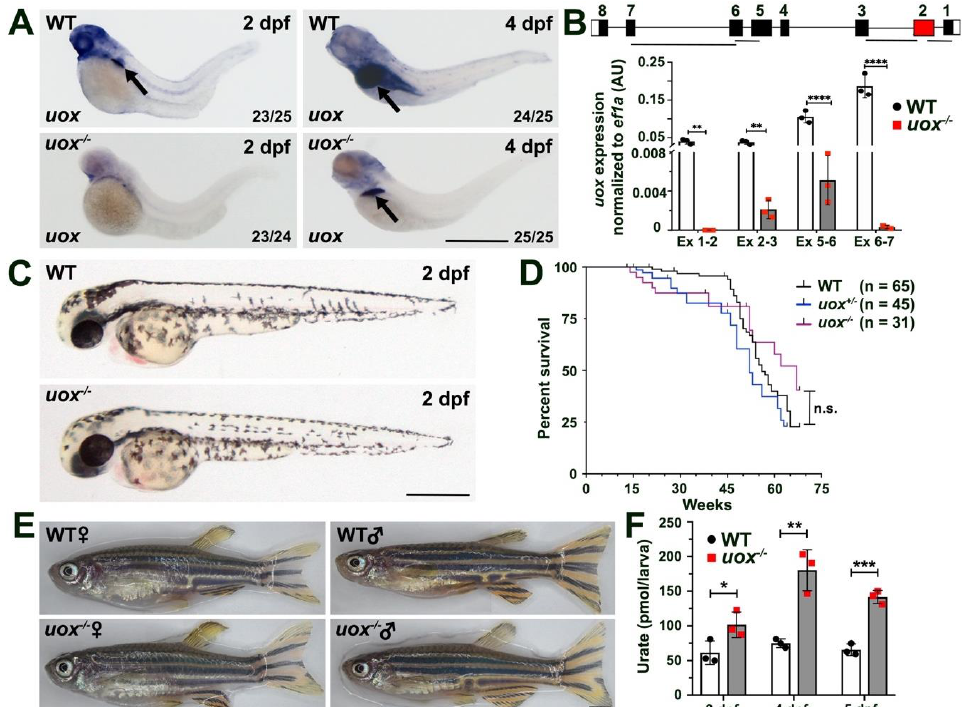
Figure 3. The +7 bp mutation in the uox gene results a null allele and uox − / − zebrafish are morphologically normal, fertile and possess elevated levels of urate. ( A ) Expression of uox in 2 and 4 day post fertilization (dpf) WT and uox − / − larvae, as detected by WMISH (arrows mark the liver). Numbers in the lower right corner of each panel indicate the frequency of larvae showing the displayed expression pattern. ( B ) Expression of uox in WT (white bars) and uox − / − (grey bars) larvae at 4 dpf, as detected by qPCR using four independent exon-spanning primer pairs (Ex 1–2, Ex 2–3, Ex 5–6 and Ex 6–7, as shown in schematic). Data generated from three biological replicates, n = 10 larvae per group. Schematic shows the location of the four primer pairs in the uox gene. Statistical significance determined using multiple unpaired Student’s t-tests with Holm–Sidak correction. ( C ) Representative brightfield images of WT and uox − / − larvae at 2 dpf. ( D ) Kaplan–Meier survival curve of WT, uox +/ − and uox − / − fish from 1 month to 18 months of age. Statistical significance determined using the log-rank (Mantel–Cox) test. ( E ) Representative brightfield images of age-matched female and male WT and uox − / − adult fish. ( F ) Quantification of urate (pmol urate/larvae) from dissociated 3, 4 and 5 dpf WT (white bars) and uox − / − (grey bars) larvae, as detected using a Roche C311 autoanalyzer. Data generated from three biological replicates, n = 40 larvae per group. Statistical significance determined using multiple unpaired Student’s t-tests. Error bars in ( B , F ) represent means ± SDs. Abbreviations: n.s. not significant, * p < 0.05, ** p < 0.01, *** p < 0.001 and **** p < 0.0001. Scale bars: 500 µ m in ( A , C ), 2 mm in ( E